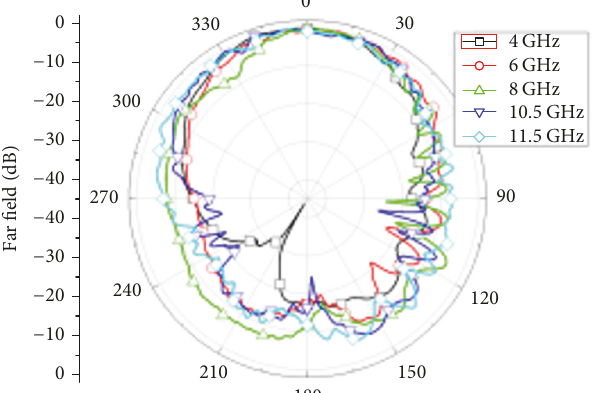
Figure 14: The measured far field pattern of Ant2 at 4GHz, 6GHz, 8 GHz, 10.5 GHz, and 11.5GHz.